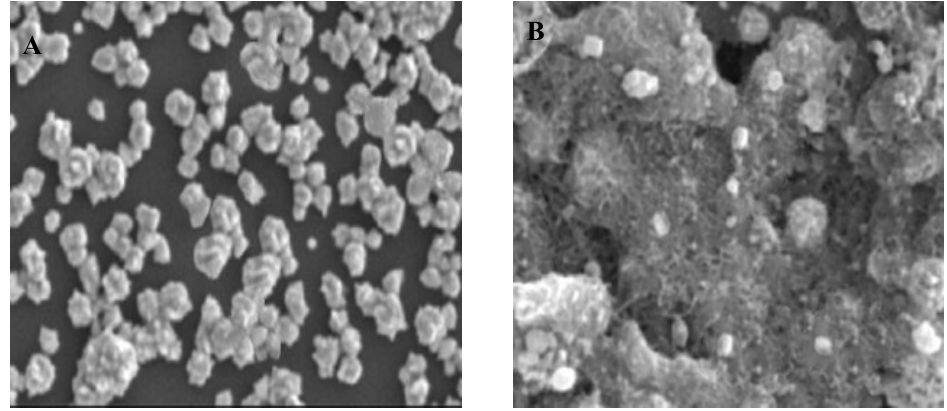
Figure 2. SEM images of MWNT(SH)–Au (a) and (b) MWNT(SH)–Au/IL.